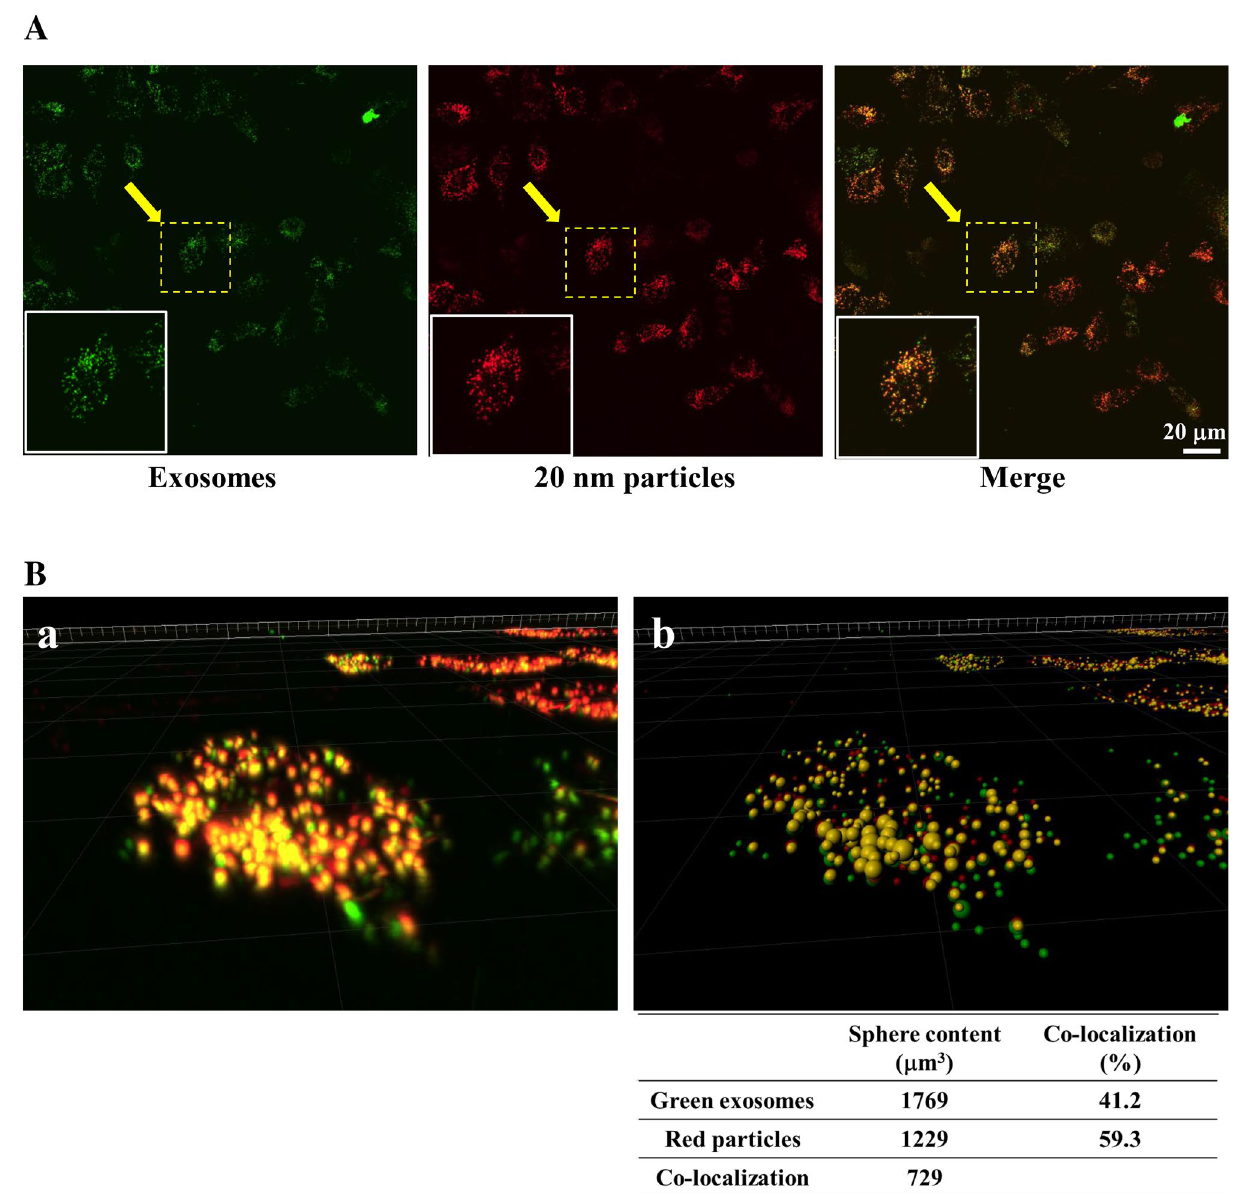
Figure 5. Localization of green fluorescent exosomes or 20-nm red fluorescent nanoparticles in CHO-MARCO cells. ( A : CHO-MARCO cells were cultured with both green fluorescent exosomes and 20-nm red fluorescent nanoparticles for 6 h. The localization of exosomes and nanoparticles were observed using confocal super- resolution microscopy. ( B ) Images collected from the multiple Z-stacks were imported into the Imaris platform. The 3D image example of the region (surrounded by the dashed line) observed from the arrow in ( A ) is shown. (a) Image in 3D-renderings of raw data. (b) 3D visualization of the image using Imaris. For quantification of co-localized area, the individual sphere content of the 3D image was analyzed by Imaris using two channels, green and red. The percentage (%) was calculated as co-localized sphere content/each sphere content. The sphere volumes (µm 3 ) and percentages are shown below the